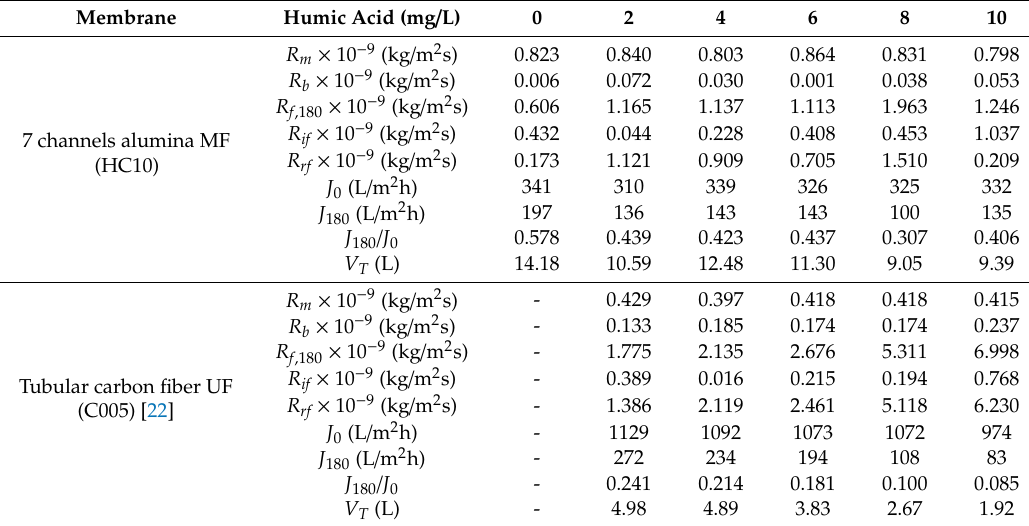
Table 2. E ff ect of humic acid (HA) on filtration factors in the hybrid process of seven-channel alumina MF (HC10) membrane and PP beads with periodic water backwashing (BT 10 s, FT 10 min) as compared with the results of tubular carbon fiber UF (C005) membrane.